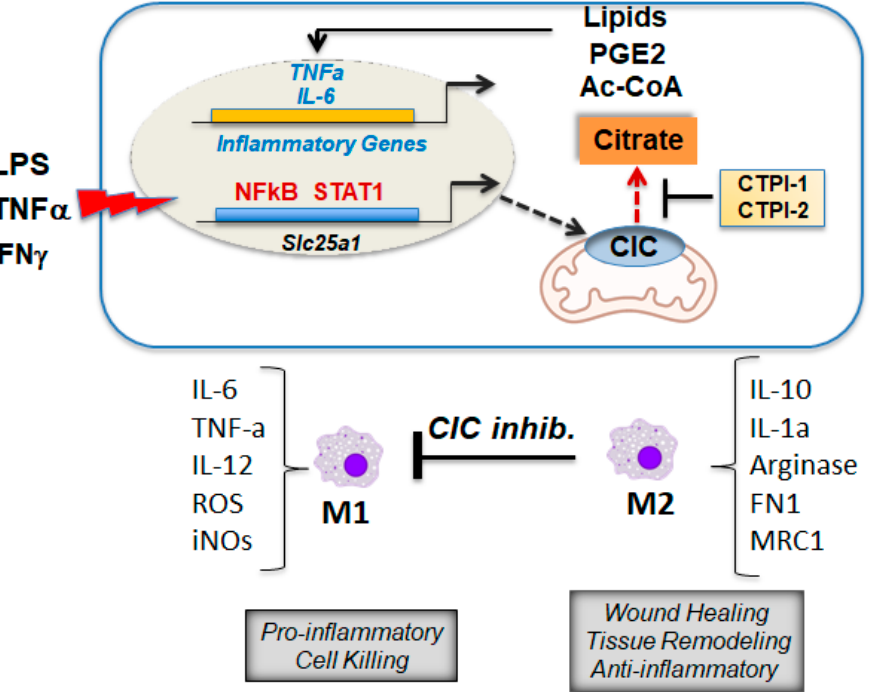
Figure 7. CIC induces a pro-inflammatory program in macrophages (see text for explanation). The transcription rate of the SLC25A1 gene is induced in monocytes by lipopolysaccharides (LPS), tumor necrosis factor alpha (TNF α ) and interferon gamma (IFN γ ) via recruitment to the promoter of nuclear factor kappa B (NFkB) and signal transducer and activator of transcription 1 (STAT1). CIC induction in these situations leads not only to the expected increase in Ac-CoA but also to enhanced synthesis of prostaglandin E2 (PGE2) and inducible nitric oxide synthetase (iNOS). At the bottom of the figure, there is a simplistic representation of the macrophage populations depicted in the two opposite phenotypes, M1 and M2. In the NAFLD/NASH liver, CIC inhibition represses markers of the pro-inflammatory macrophage phenotype. Abbreviations that are not in the main text: reactive oxygen species, ROS; iNOS, inducible nitric oxide synthase; FN1, fibronectin 1; MRC1, Mannose Receptor C-Type 1.